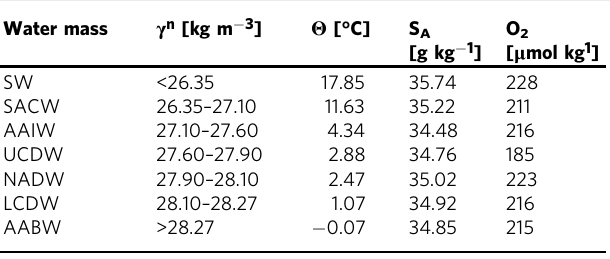
Table 1 De fi ning features of water masses in the subtropical South